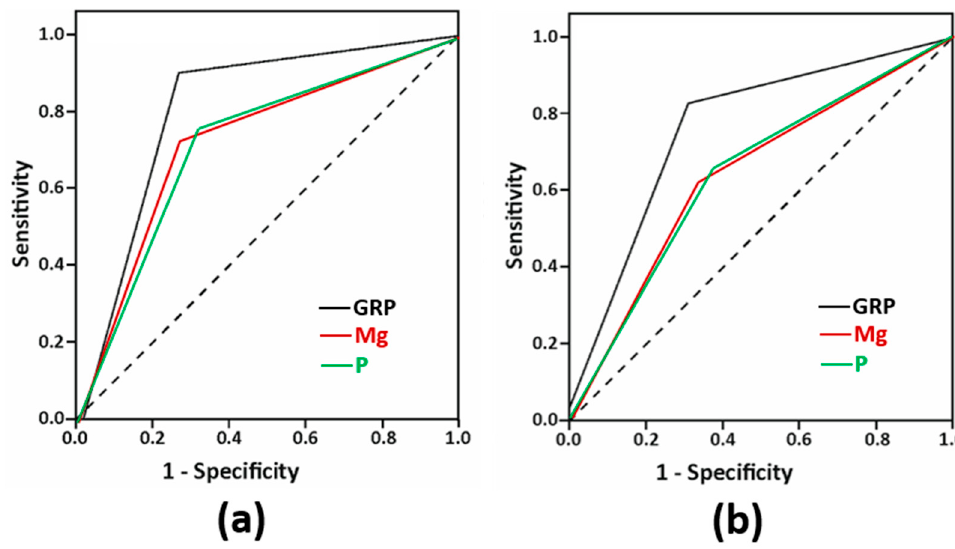
Figure 3. Receiver operating characteristic (ROC) curves of serum GRP, magnesium (Mg) and phosphate (P) for aortic valve calcification ( a ) and mitral valve calcification ( b ).